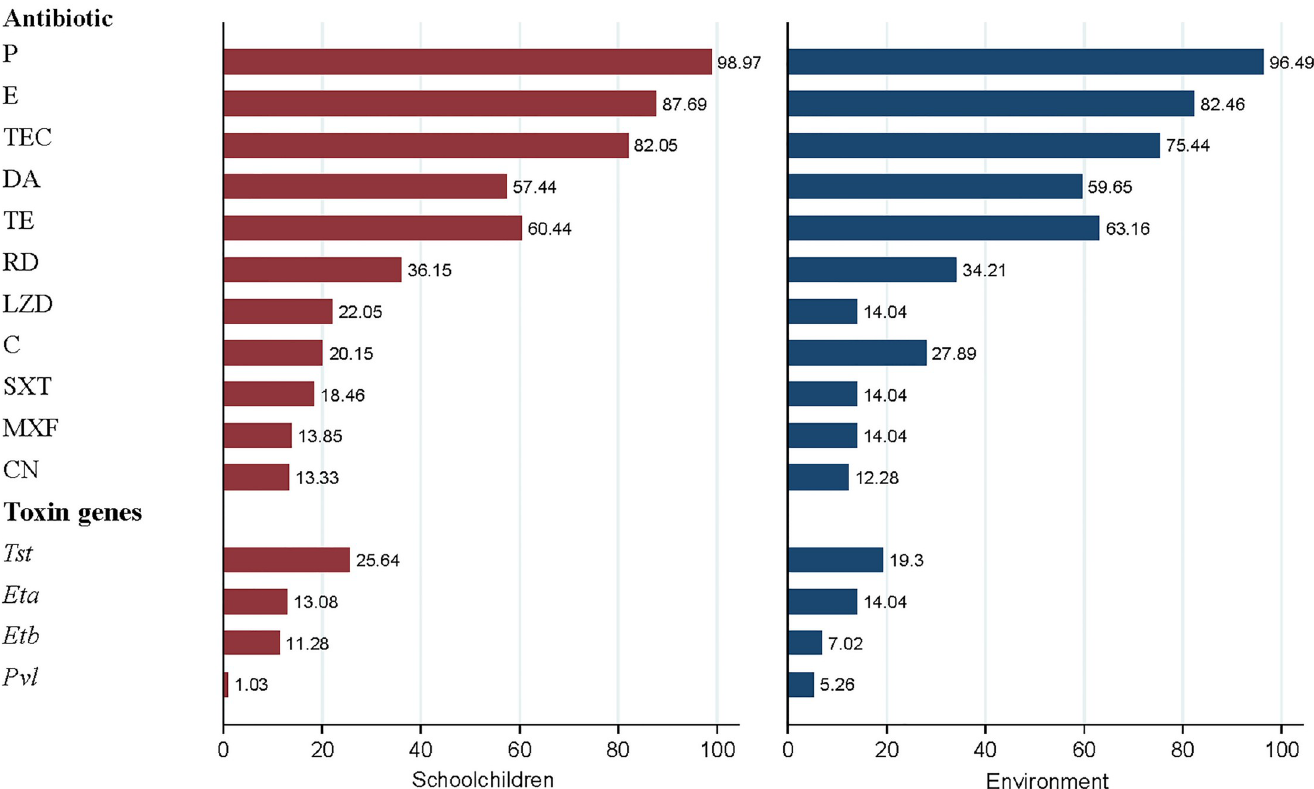
Fig 1. Prevalence of antibiotic resistance and genetic carriage in MSSA isolates between schoolchildren and environment, Guangzhou, 2016. P, Penicillin; E, Erythromycin; TEC, Teicoplanin; DA, Clindamycin; TE, Tetracycline; RD, Rifampin; LZD, Linezolid; C, Chloramphenicol; SXT, Trimethoprim-sulfamethoxazole; MXF, Moxifloxacin; CN,